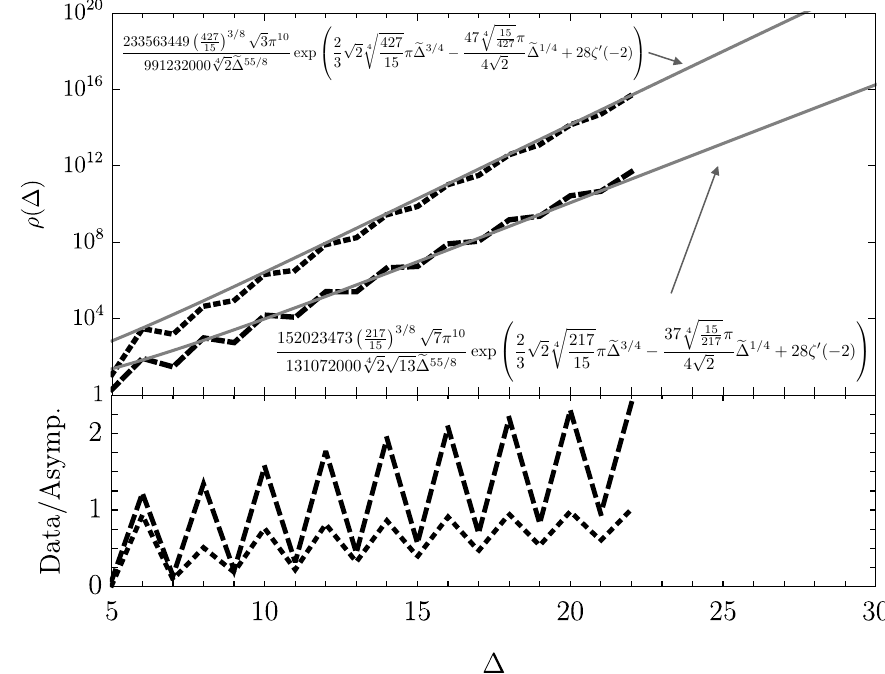
Figure 5: The growth of operators in the SMEFT, comparing exact data with the asymptotic formulae. The thick dashed curve is data for one generation of fermions, = 1; the thick dotted curve is data for three generations of fermions N N g solid grey curves indicate the asymptotic result Eq. (145) evaluated with the shifted ∆ given by Eq. (cid:101)